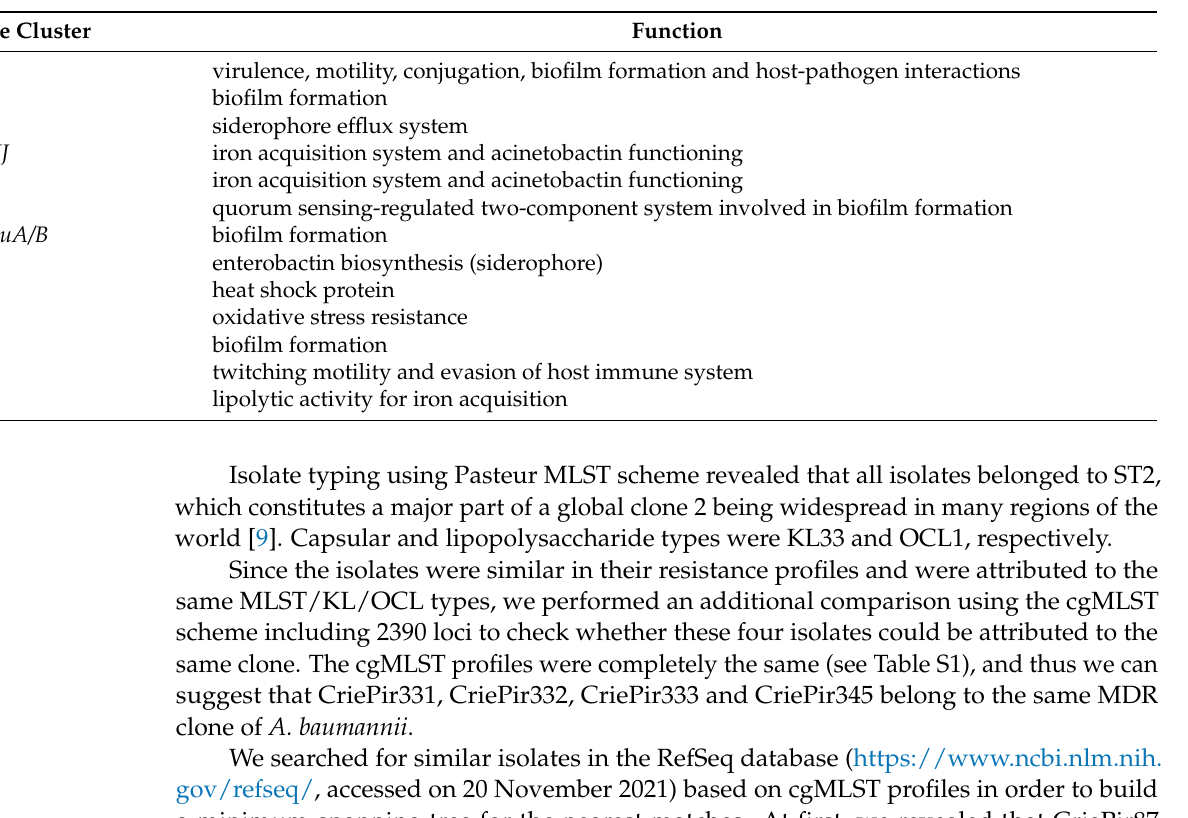
Table 3. Virulence and heavy metal resistance-associated genes of A. baumannii